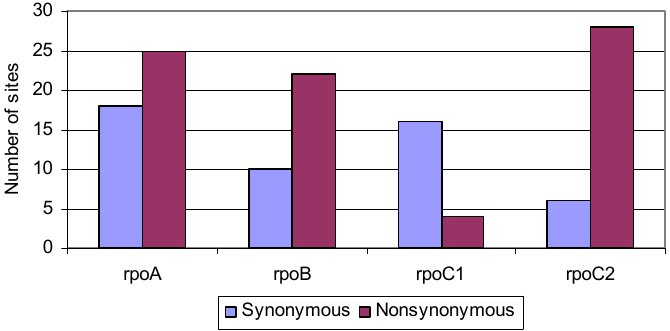
Figure 6. Number of sites containing synonymous and nonsynonymous substitutions (an outgroup not